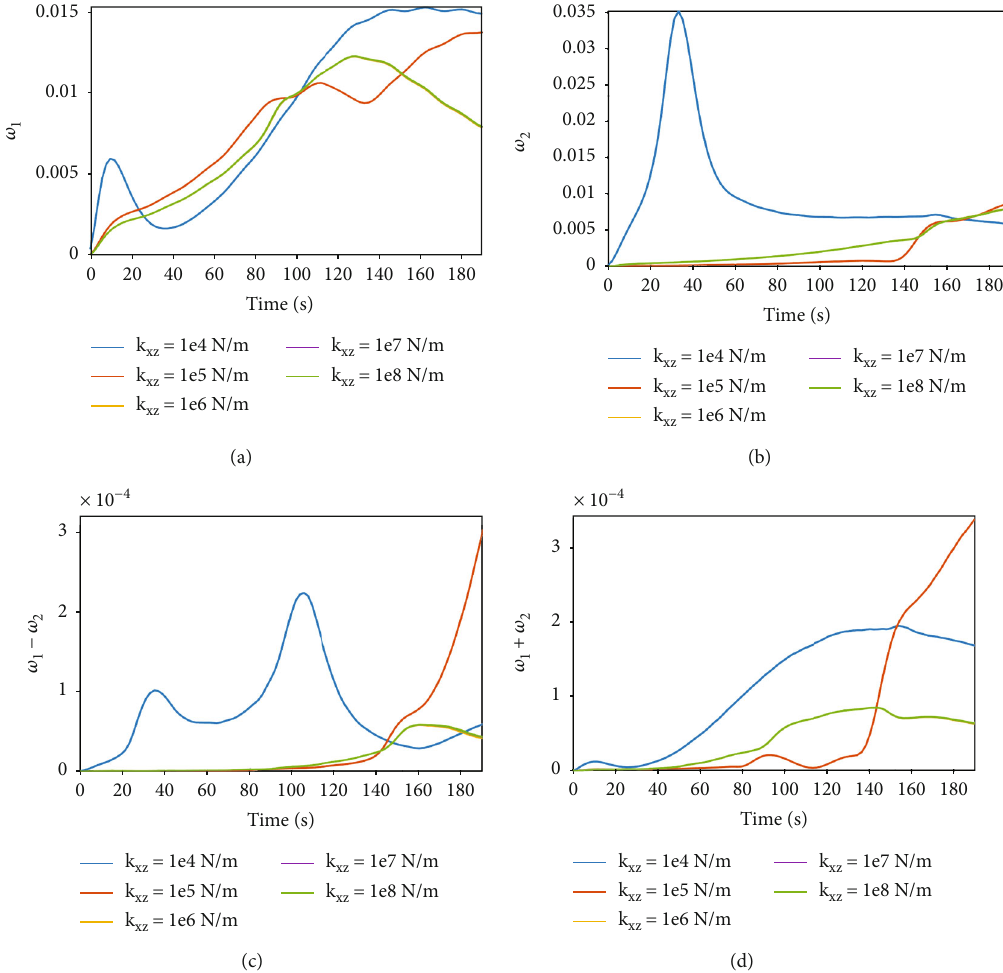
ω ω − ω ω + ω 1 ; (b) 2 ; (c) 1 2 ; (d) 1 2 .